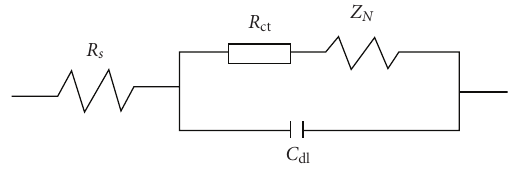
Figure 7: Equivalent circuit for the electrochemical impedance spectra in Figure 6 ( R s : Ohmic series resistance, R ct : The charge- transfer resistance, C dl : Capacitance of electric double layer, and Z N : Nernst di ff usion impedance).